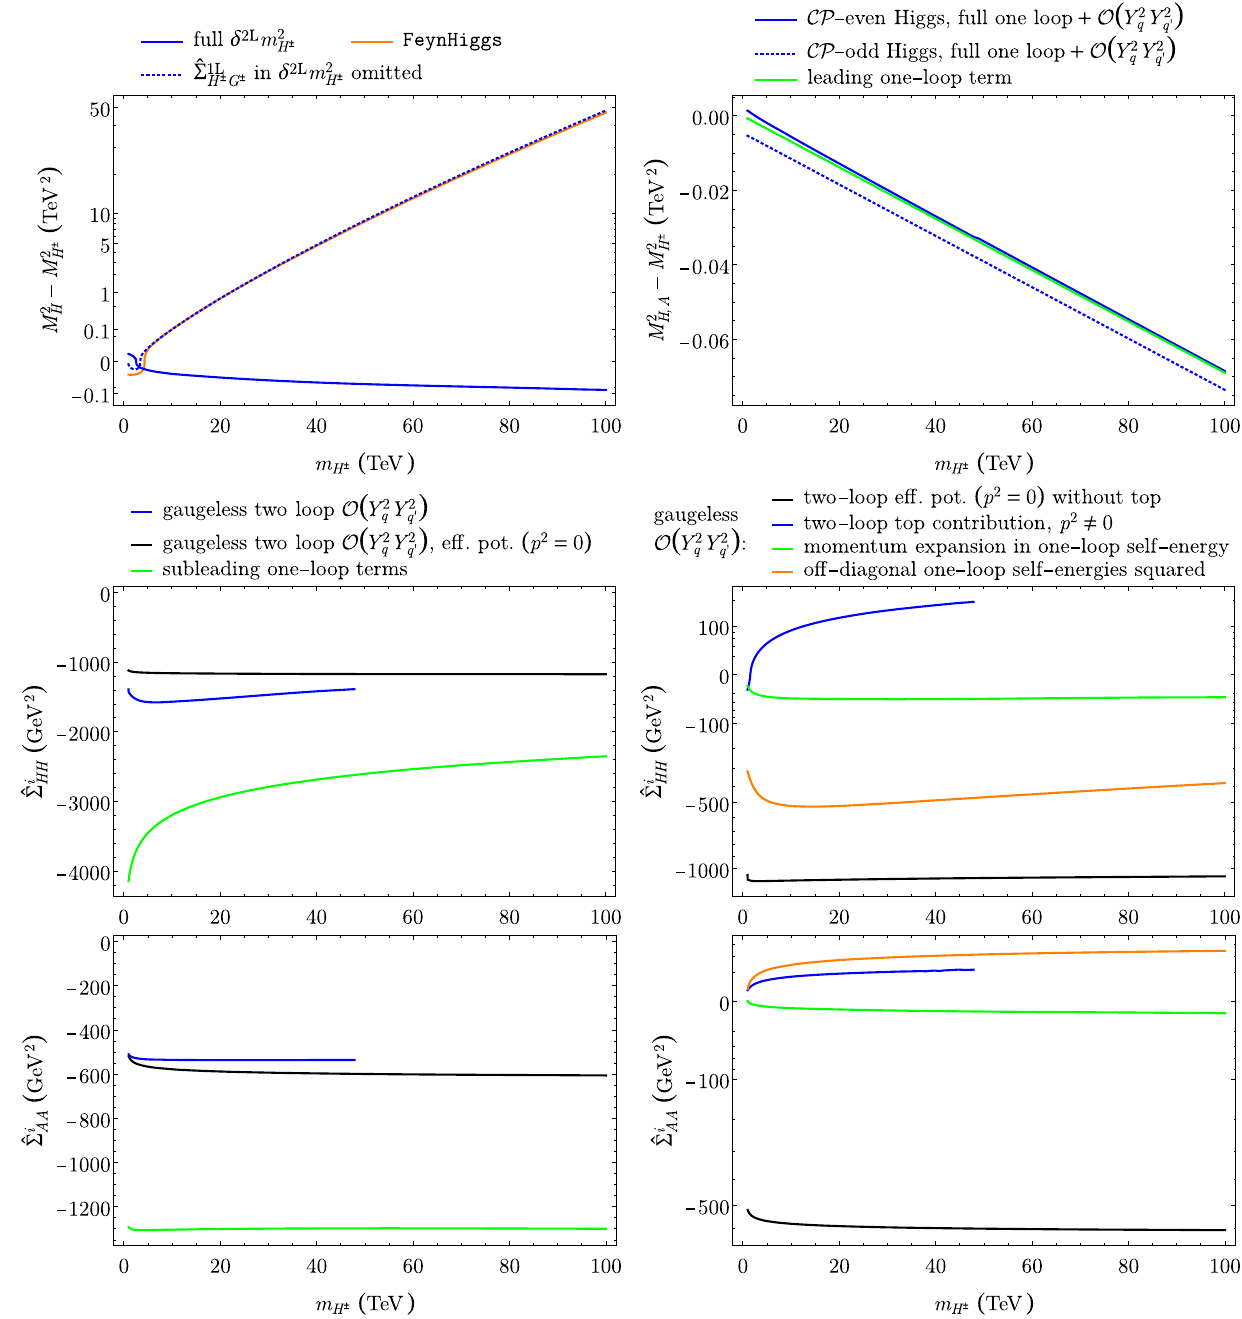
Fig. 8 Contributions to the squared mass-splitting for the heavy- doublet states in the scenario of Fig.7. Upper left: One-loop and O ( Y 4 q ) two-loop contributions to the squared mass-splitting between the CP - even and charged Higgs in FeynHiggs-2.16.0 (orange), in our calculation (solid blue), and omitting the off-diagonal contribution to Eq.(21) (dotted blue). Upper right: One-loop and O ( Y 4 q ) two-loop con- tribution to the squared mass-splitting between the neutral ( CP -even: solid blue; CP -odd: dotted blue) and charged Higgs; the leading one- loop contribution from gauge corrections is shown in green; Middle left: Contributions to the CP -even self-energy beyond the leading one-